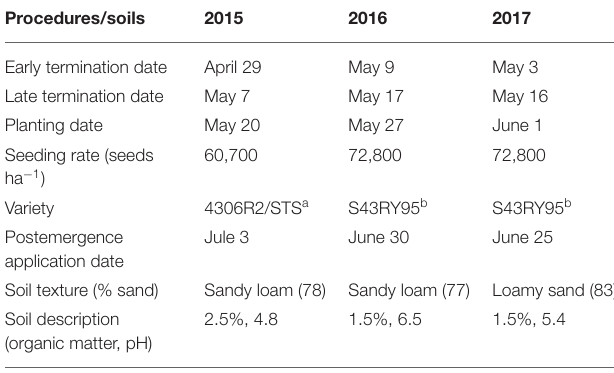
TABLE 1 | Dates of field procedures and soil